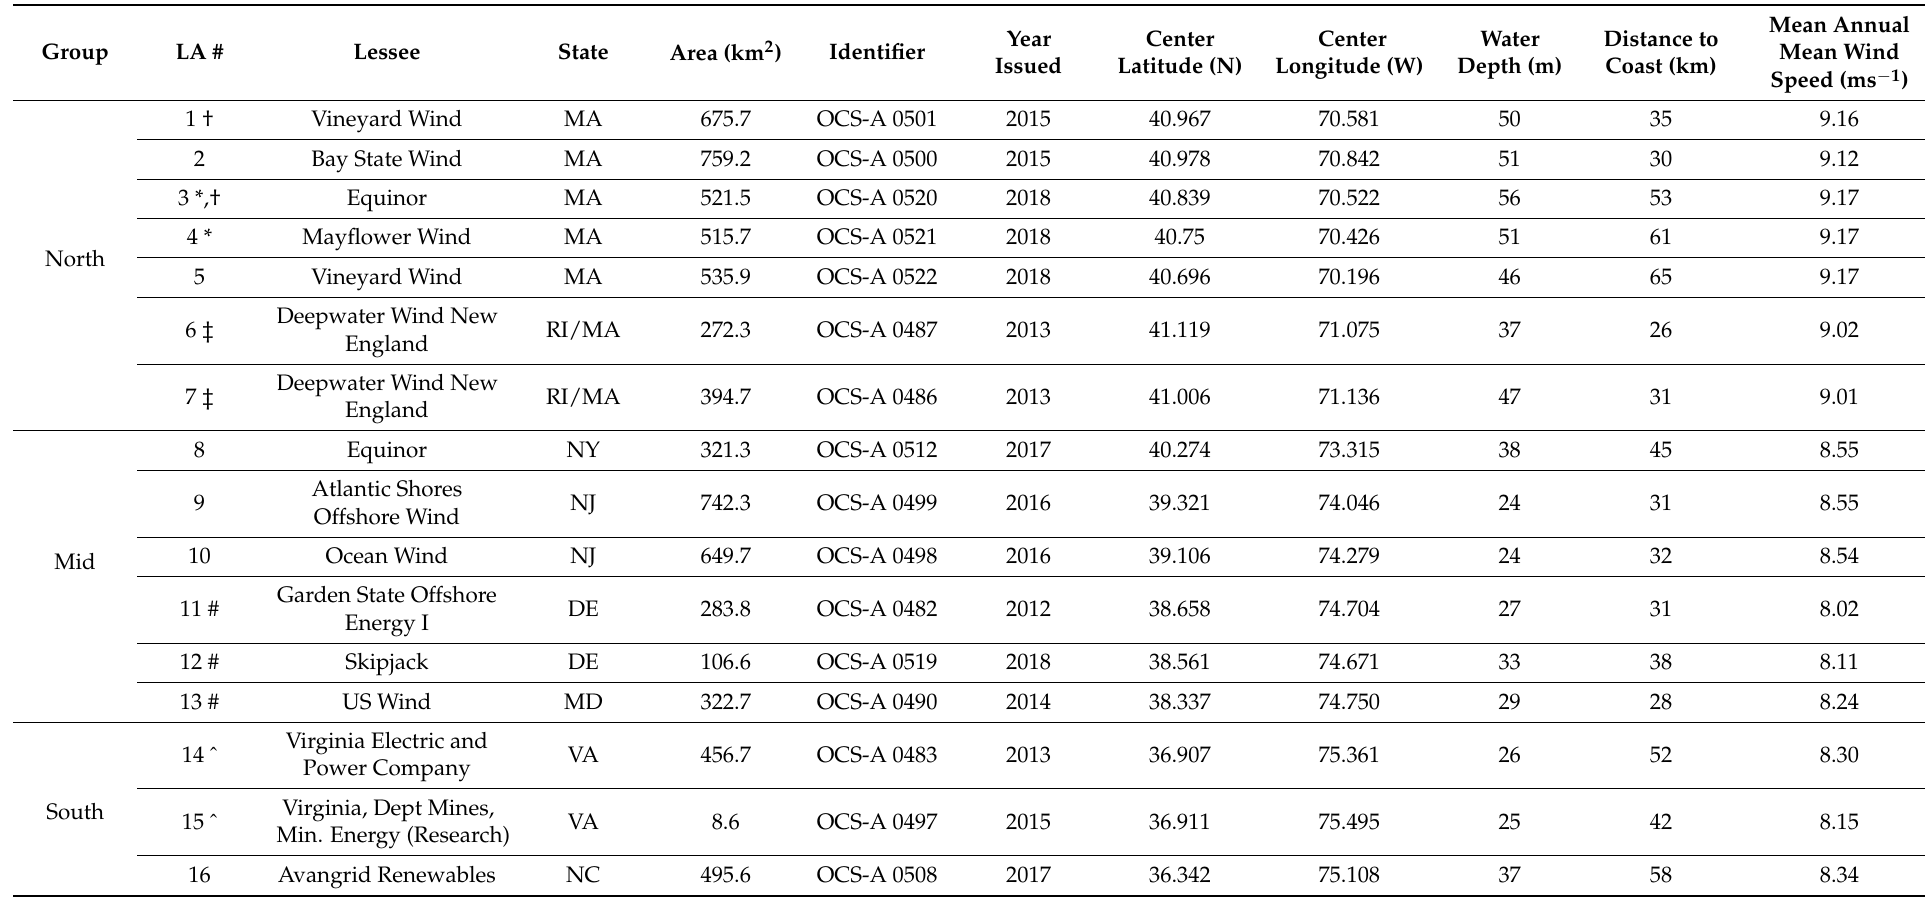
Table 2. Offshore LA for wind developments off the U.S. east coast. Data from https://www.boem.gov/renewable-energy/lease-and-grant-information and https://maps.ngdc.noaa. gov/viewers/bathymetry/ and https://oceancolor.gsfc.nasa.gov/docs/distfromcoast/. Centre latitudes and longitudes are estimated from shapefiles available from BOEM [14]. * in second column denote LA that fall within the same ERA5 grid cell for wind speeds (LA 3 and 4). †, ‡, # and ˆ in second column denote LA that fall within the same ERA5 grid cell for waves (LA 1 and 3, 6 and 7, 11–13 and 14 and 15, respectively). The final column shows the mean annual mean wind speed computed from the ERA5 hourly output at 100 m